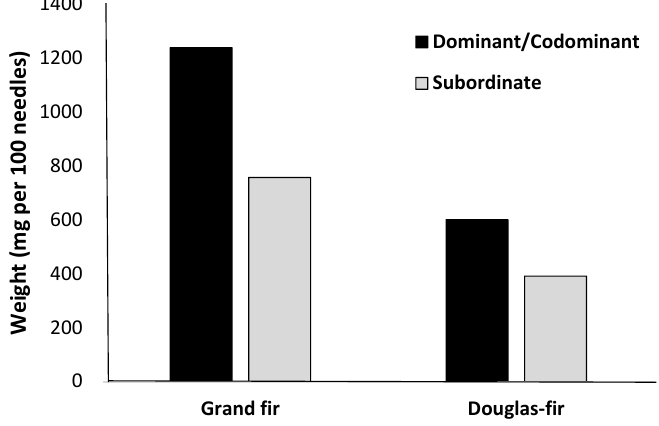
Figure 3. Total nitrogen (N), phosphorus (P), potassium (K), calcium (Ca), and sulfur (S) content of aboveground portion of four inland tree species: grand fir, Douglas-fir, ponderosa pine, and lodgepole pine [16].